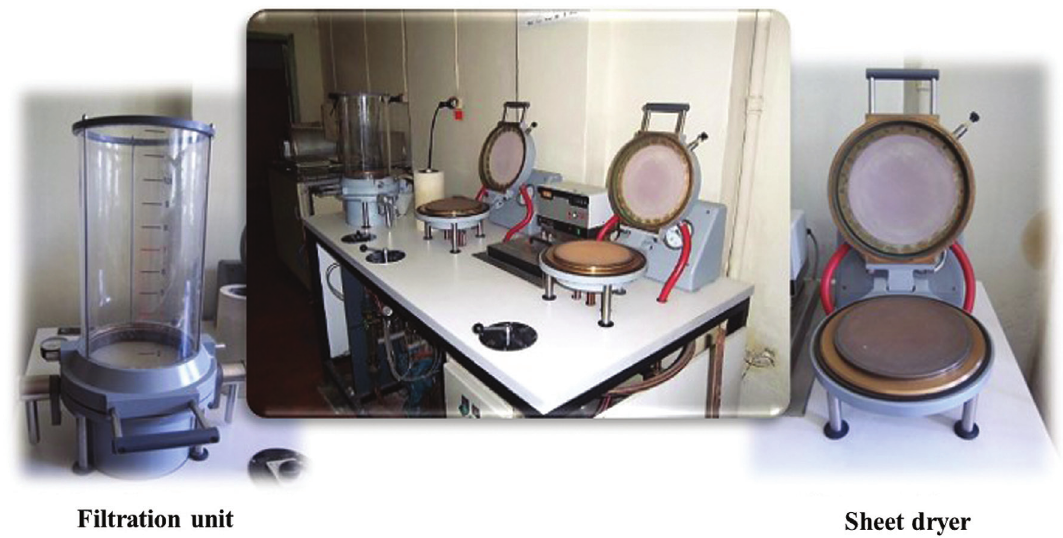
Figure 1: Rapid Köthen sheet former used to prepare cellulose samples.